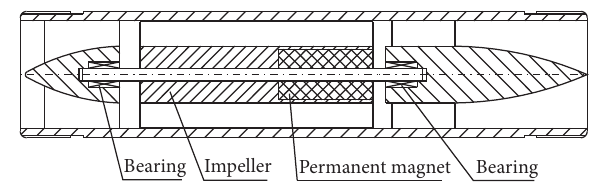
Figure 1: Schematic of axial-flow blood pump.